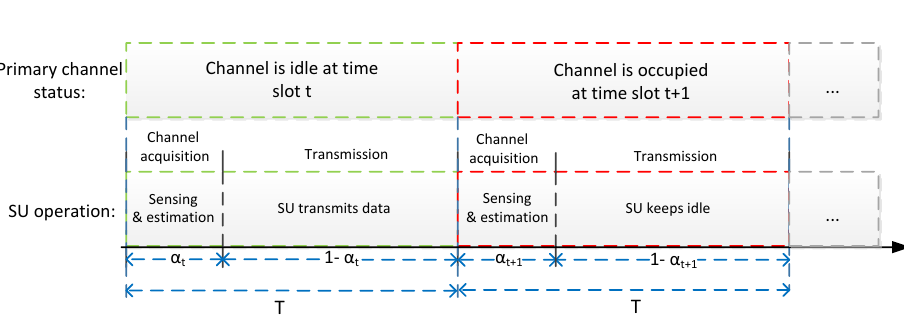
Figure 1. The allocation of time durations: channel acquisition phase versus transmission